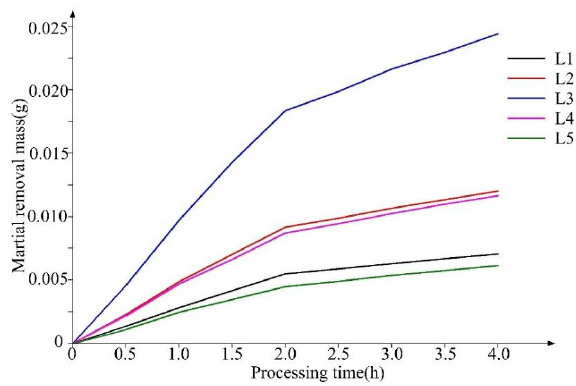
Figure 27. Curve of material removal mass.